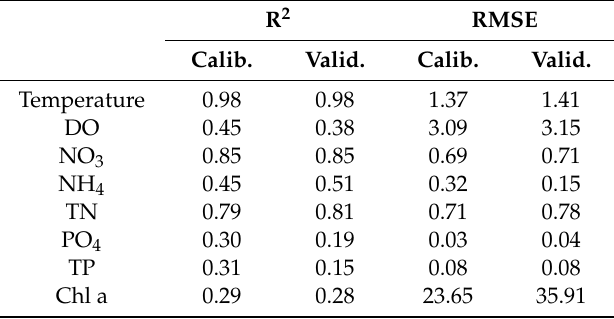
Table 2. Root-mean-square-error (RMSE) values and coe ffi cients of determination (R 2 ) between simulated model output and observations separated in calibration and validation. R 2 RMSE Calib. Valid. Calib. Valid. Temperature 0.98 0.98 1.37 DO